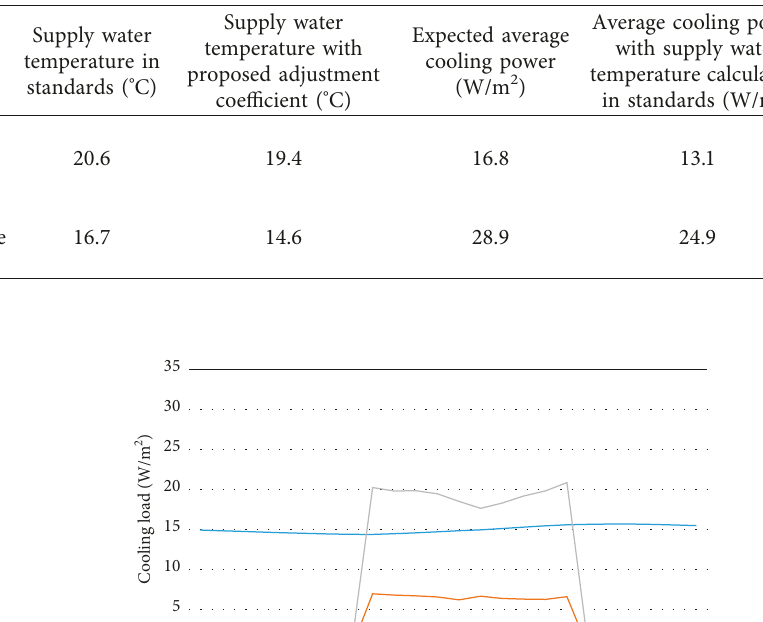
Table 4: Comparison of supply water temperature and average cooling power with the proposed method.